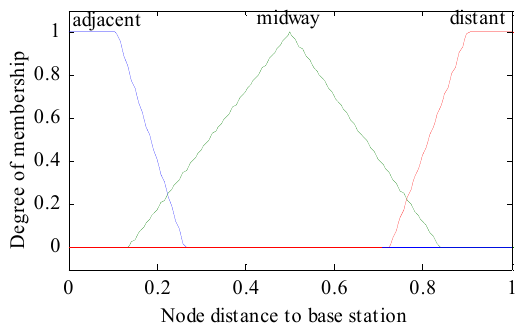
Figure 1. Membership function of RE (residual energy).